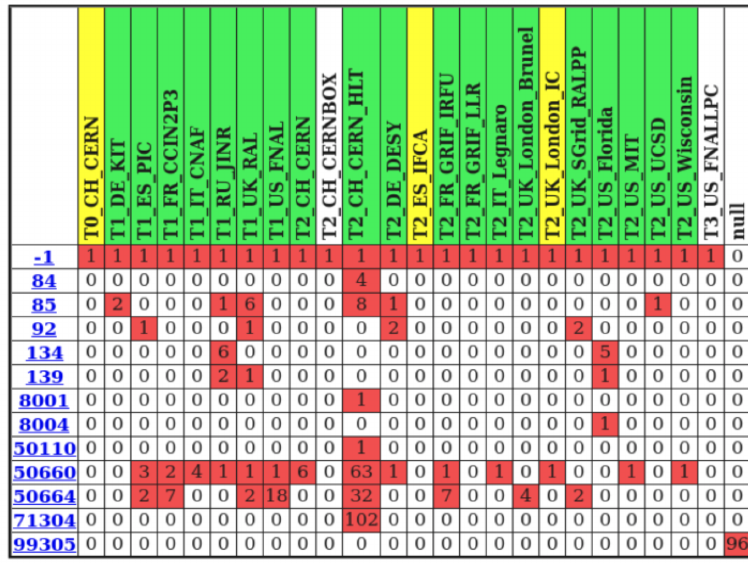
Figure 1: Example for a sparse error-site matrix. The entries of the matrix are the number of times an error code has been